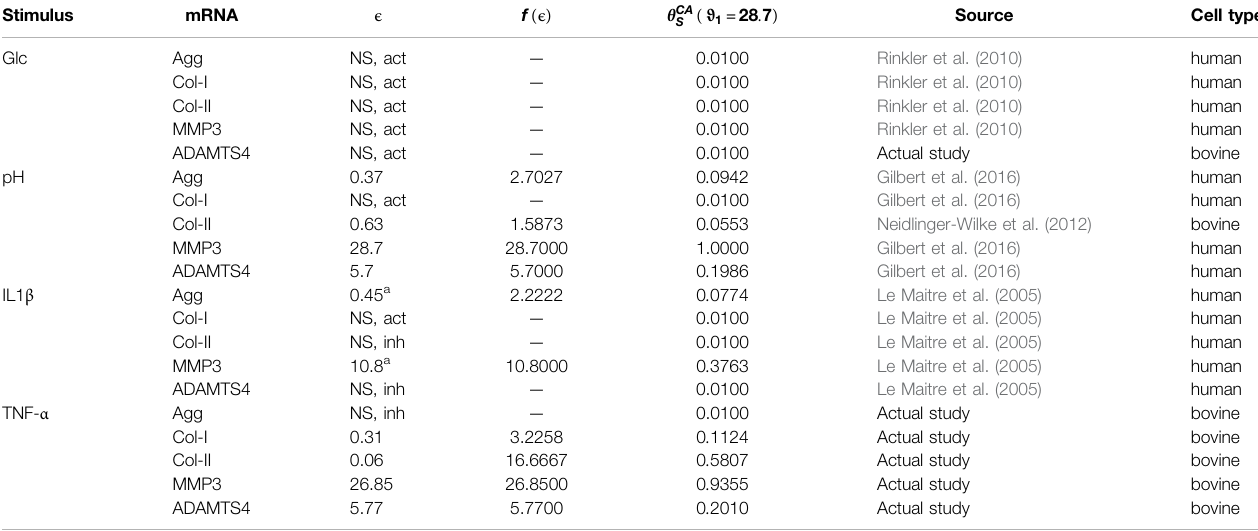
TABLE 1 | Individual weighting factors for the tackled PN-system, i.e., 1st, 2nd and 3rd level CA ( Figure 1 ), along with the scaling factors and cellular efforts. Individual weighting factors were derived from the cellular effort [ f ( ϵ ) ], based on x-fold mRNA expressions ( ϵ ). The scaling factor ϑ θ relationship